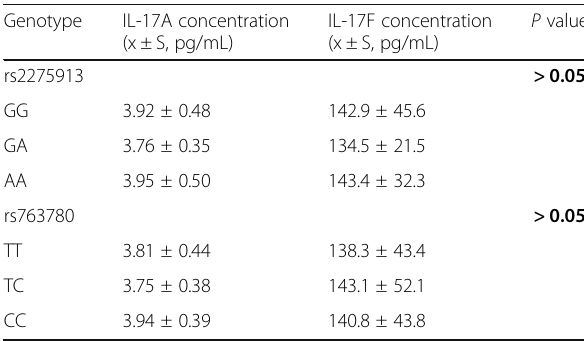
Table 4 The serum levels of IL-17A and IL-17F in the different